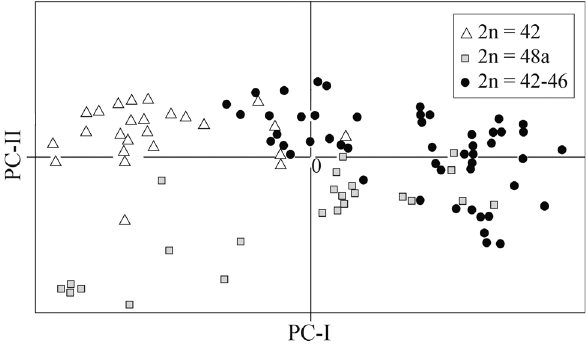
Figure 3 - Scores of individual microsatellite genotypes of C. minutus plottedonthefirsttwoaxes(PC-I,PC-II)ofaprincipalcomponentsanaly-